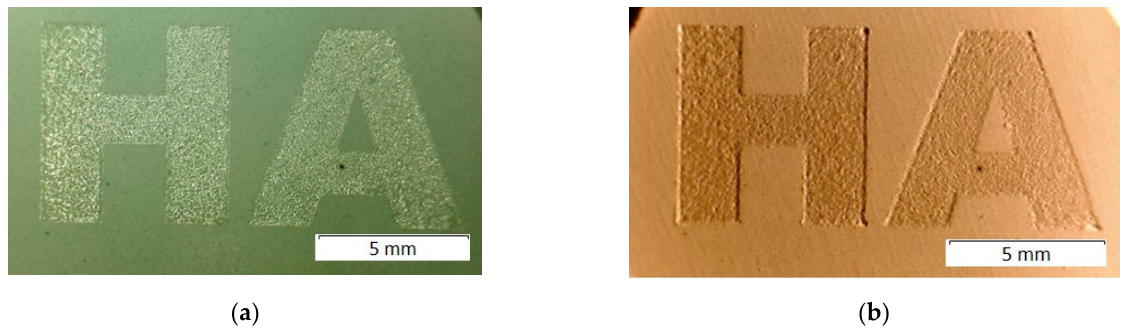
Figure 1. General view of the surface of the pellet partially treated with laser irradiation. Lighting from the top ( a ) and from the right side ( b ).